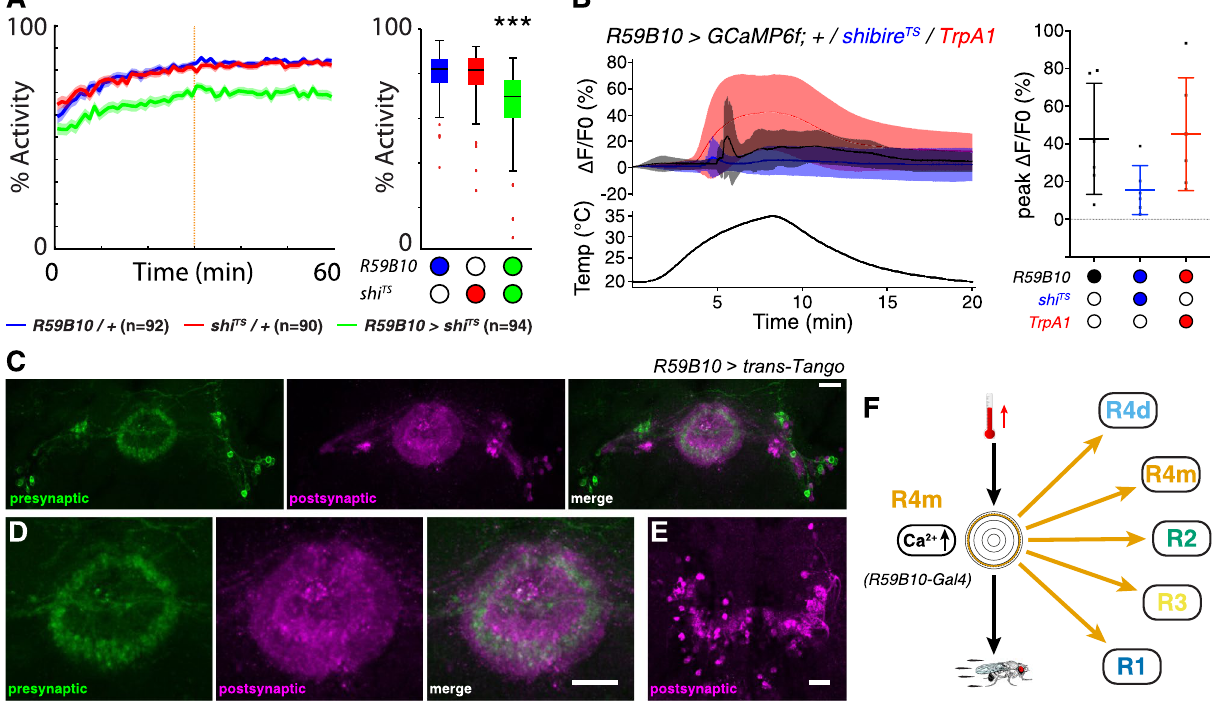
Figure 5. R4m ring neurons mediate temperature integration and thermoresponsive motor behavior. ( A ) Locomotor activity of R4m— R59B10 > Gal4 flies recorded at 31 °C (motor stimulation indicated by orange dashed line); R4m-specific output inactivation by shibire TS (green) reduced temperature-induced locomotion compared to Gal4 (blue) and UAS controls (red). Solid line, mean; shaded area, SEM; box and whiskers, median, IQR, Tukey. ( B ) Average (left) and peak (right) GCaMP responses of R4m— R59B10 > GCaMP6f brains to temperature ramps from 20 to 35 °C for control (black), co-expressing shibire TS (blue) or co-expressing TrpA1 (red) reveals a similar peak Ca 2+ influx for control and TrpA1 compared to only a small influx for shibire TS . Mean ± SD, n = 6. ( C ) trans -Tango based anterograde transsynaptic tracing of R59B10 - targeted R4m ring neurons with presynaptic signal (left, green), postsynaptic targets (middle, magenta) and merged image (right) of EB cell bodies and ring neuropil, as well as the bulb. ( D , E ) Details of trans- Tango labelling of R4m neurons indicate connections to ( C ) R1–R4 layers and ( D ) to columnar wedge neurons and the protocerebral bridge. ( F ) R4m neurons connect to all R1-R4 EB rings; they integrate temperature increase and mediate thermoresponsive motor behavior. ***p < 0.001, Kruskal–Wallis test with Dunn-Sidak correction for ( A ). Scale bars, 20 µm. See also Supplementary Figs. S1, S2 and